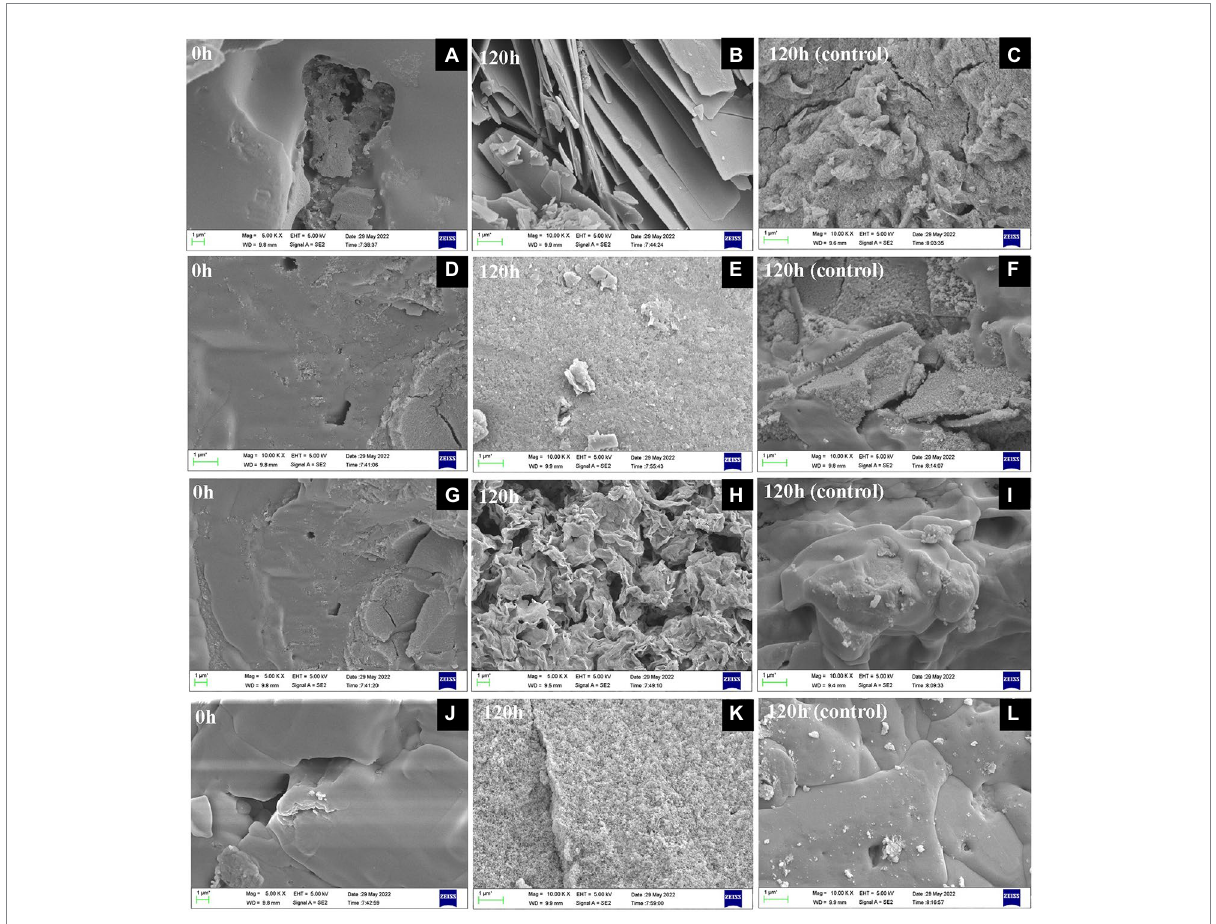
FIGURE 4 SEM observation of substances after Fe(III) reduction for 0 h (A,D,G,J) and 120 h with (B,E,H,K) and without (C,F,I,L) inoculation at 30 ° C in the absence of NaCl (A,B,C) , 30 ° C in the presence of 4% w/v NaCl (D,E,F) , 40 ° C in the absence of NaCl (G,H,I) , 40 ° C in the presence of 3% w/v NaCl (J,K,L)